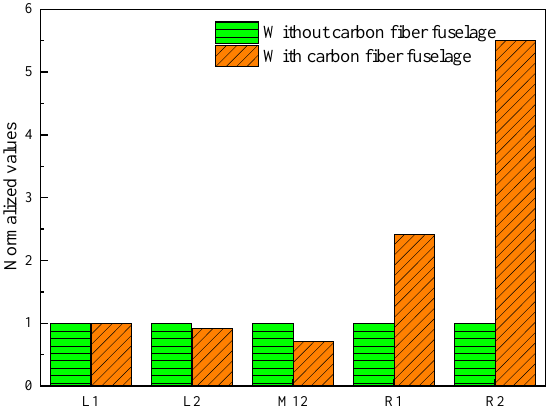
Figure 5. Mutual inductance vs. transmitter diameter and the number of